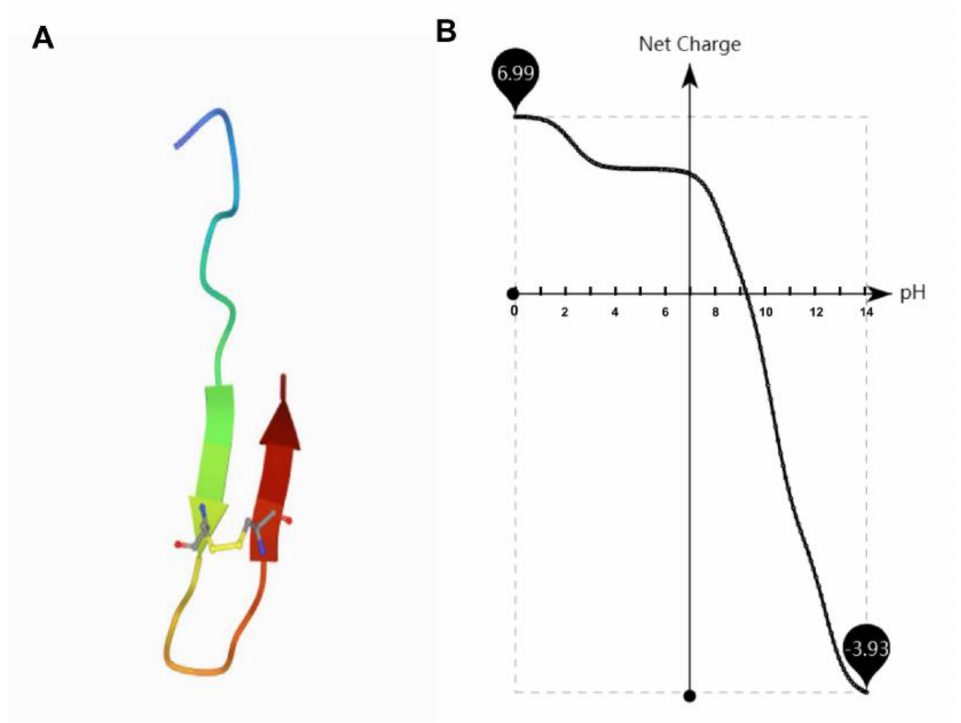
Figure 1. The structural and net charge of antimicrobial peptide TS. ( A ) Structural assembly sim- ulations of antimicrobial peptide TS. ( B ) The net charge of antimicrobial peptide TS is related to the